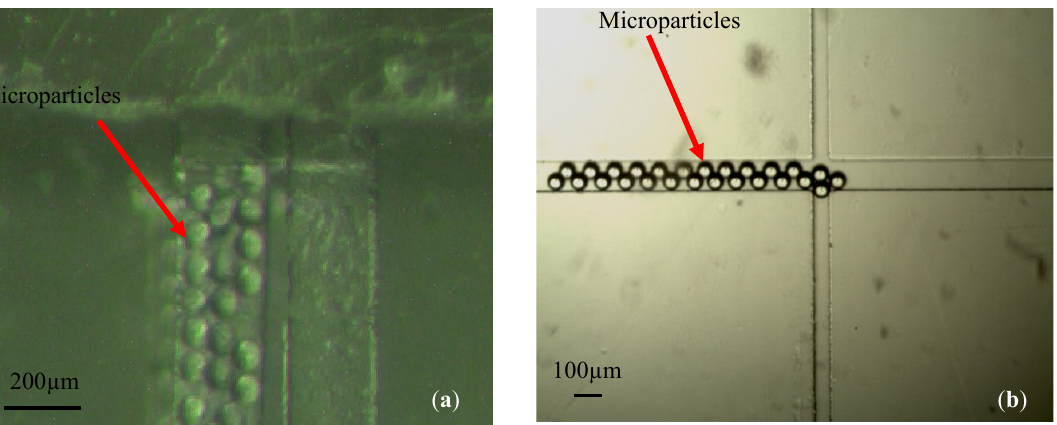
Figure 9. Polystyrene microparticles stuck inside the microfluidic channels, a) Particles clogging in the SPMF 3 , b) Particles clogging in a cross microchannel used for particle injection during some experiments .